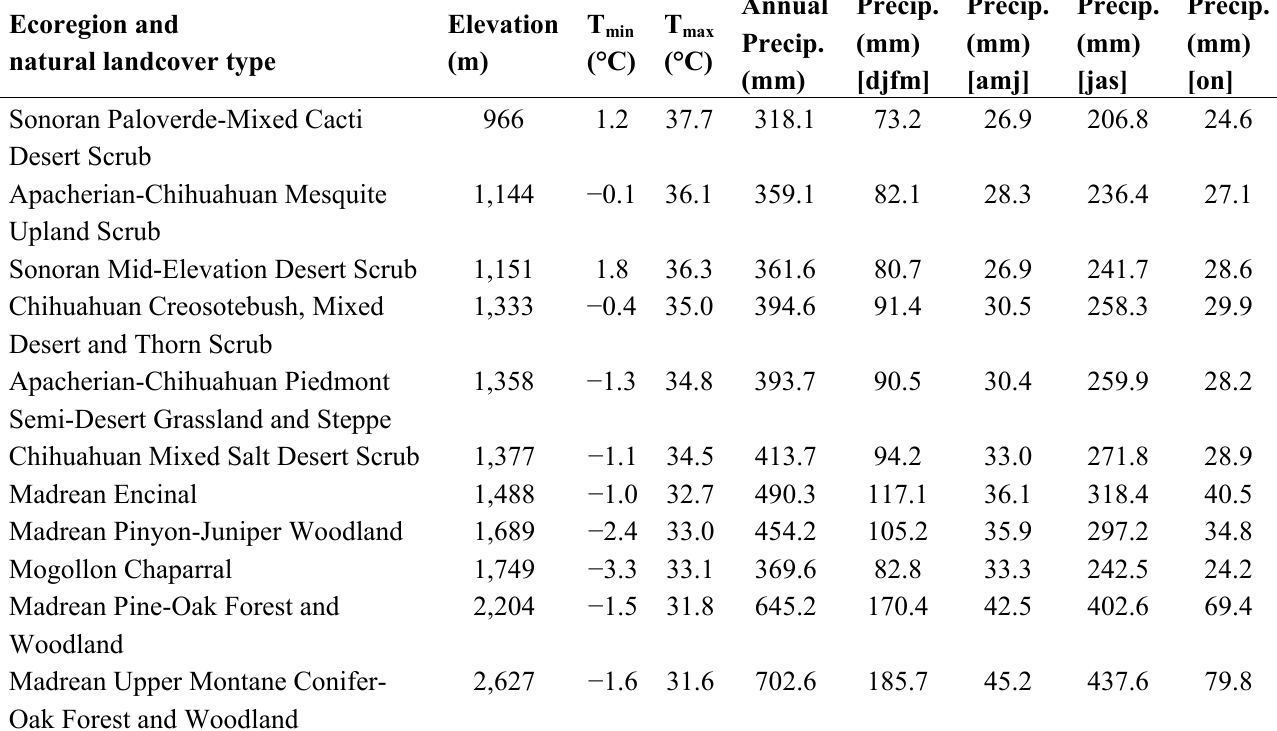
Table 1. Summary of average elevation, temperature and precipitation values for each of the natural vegetation types along the Desert-Mountain gradient as described by the SWReGAP land cover